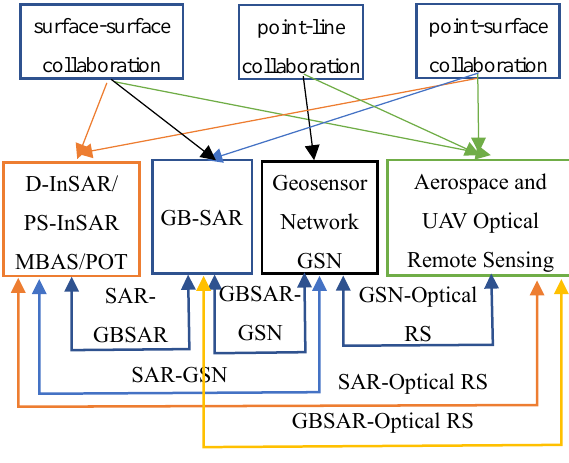
Figure 1. Collaborative Monitoring